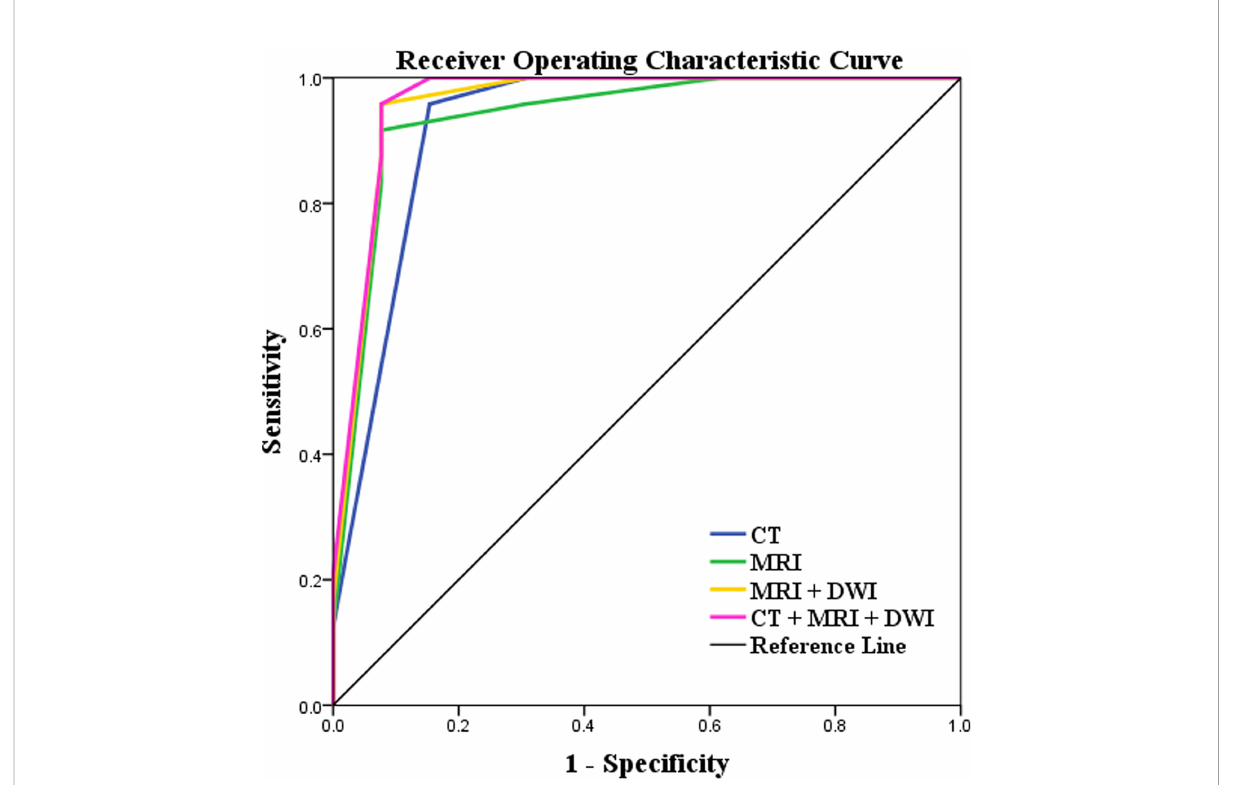
FIGURE 5 Receiver operating characteristic (ROC) curves of the characteristics of lesions on CT and MRI including DWI images for differentiating benign cystic renal masses from malignant. Combining MRI features including DWI and CT fi ndings showed the highest AUC (AUC, 0.973; Sensitivity, 100%; Speci fi city, 92.3%) in distinguishing benign and malignant